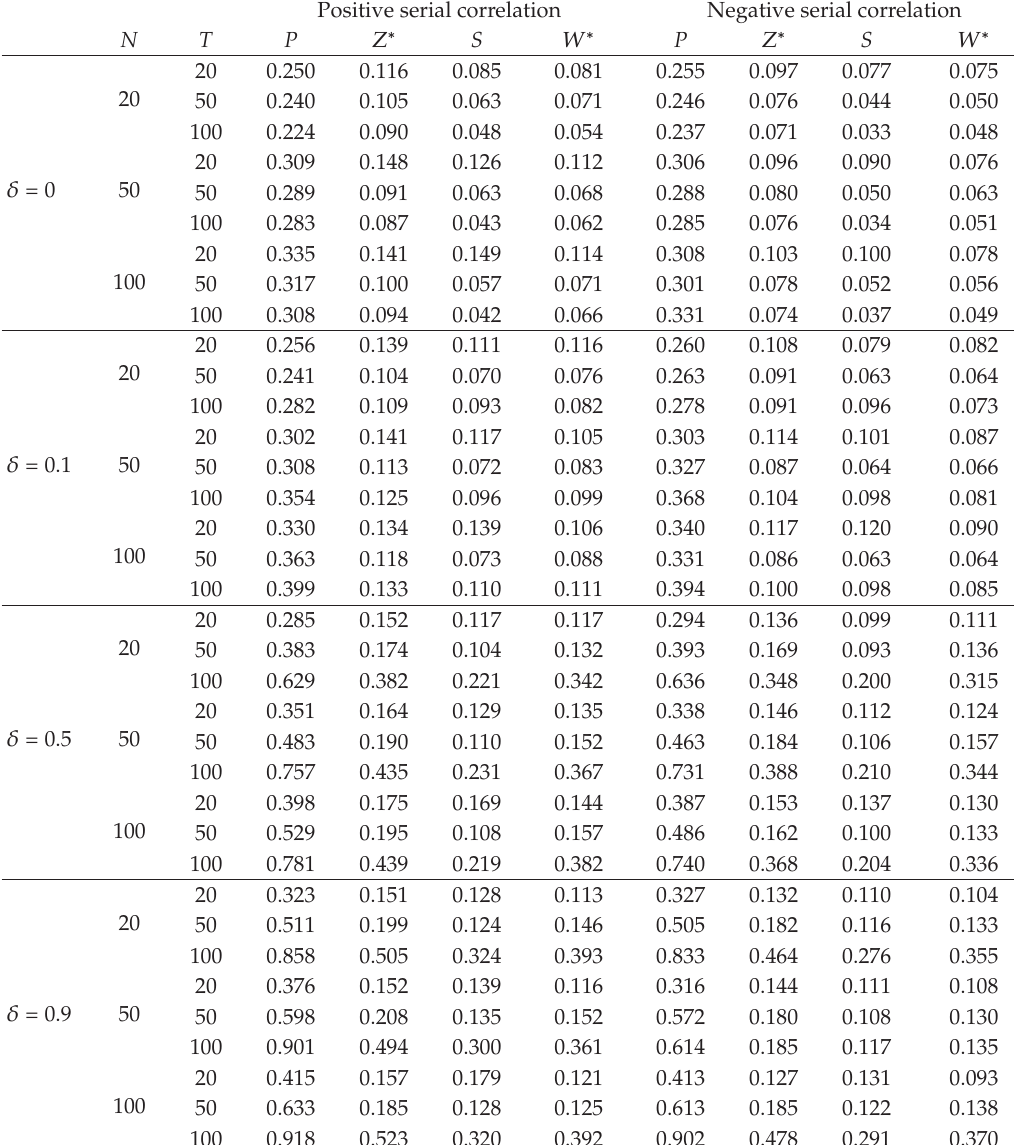
Table 3: Size and power of panel unit root tests: serial correlation, intercept only, cross-section dependence driven by a common